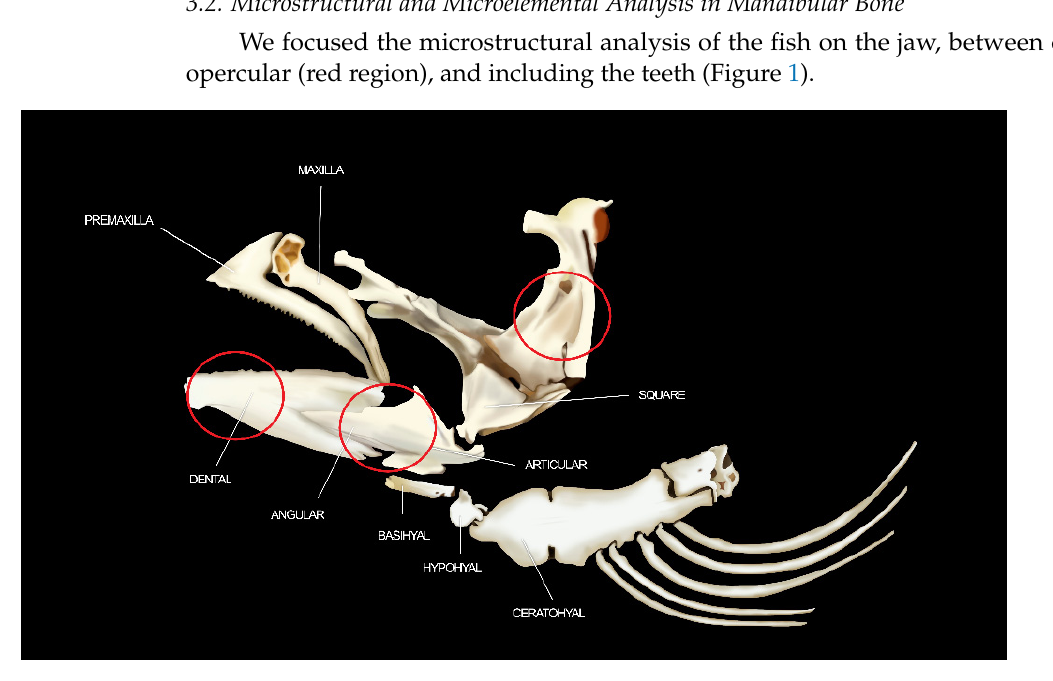
Figure 1. Diagram of the region of interest of the salmonid mandible. The mandible is formed by the dentary bone, the angular bone that enters the dentary, articular and retroarticular. In addition, the square bone is observed completing the premaxillary and maxillary articulation modified [47].